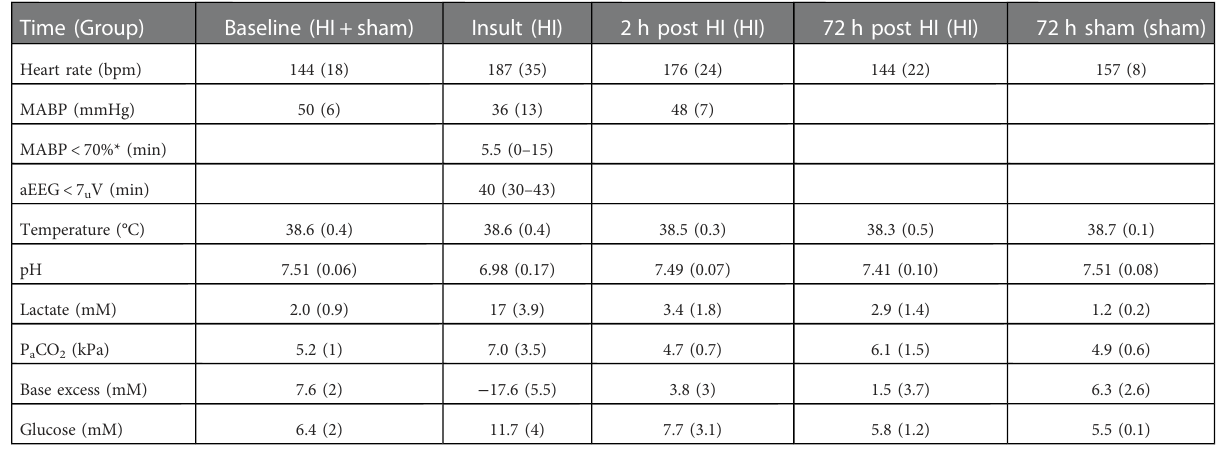
TABLE 1 Physiologic variables.